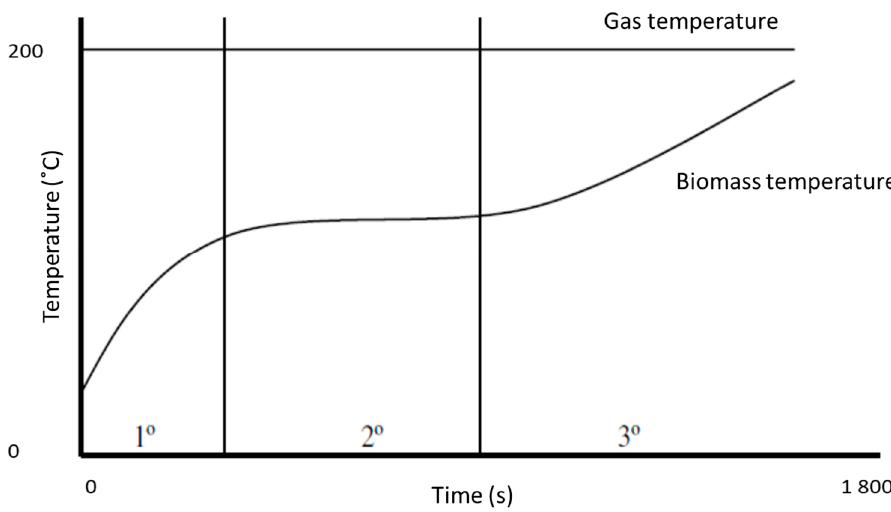
Figure 1. Temperature profile during the whole drying process [8].